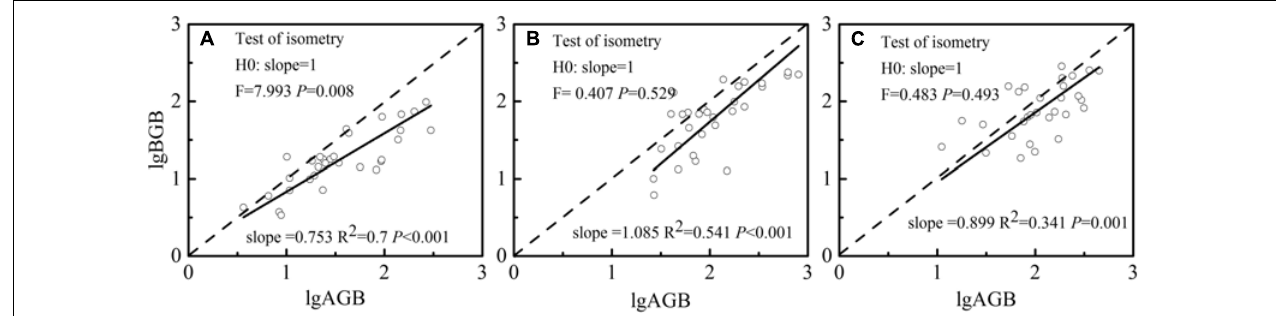
FIGURE 5 | Growth relationship and isometric test between pooled above- and belowground biomass of S. etosia (A) , R. setchuenensis (B) , and H. aspera (C), respectively.